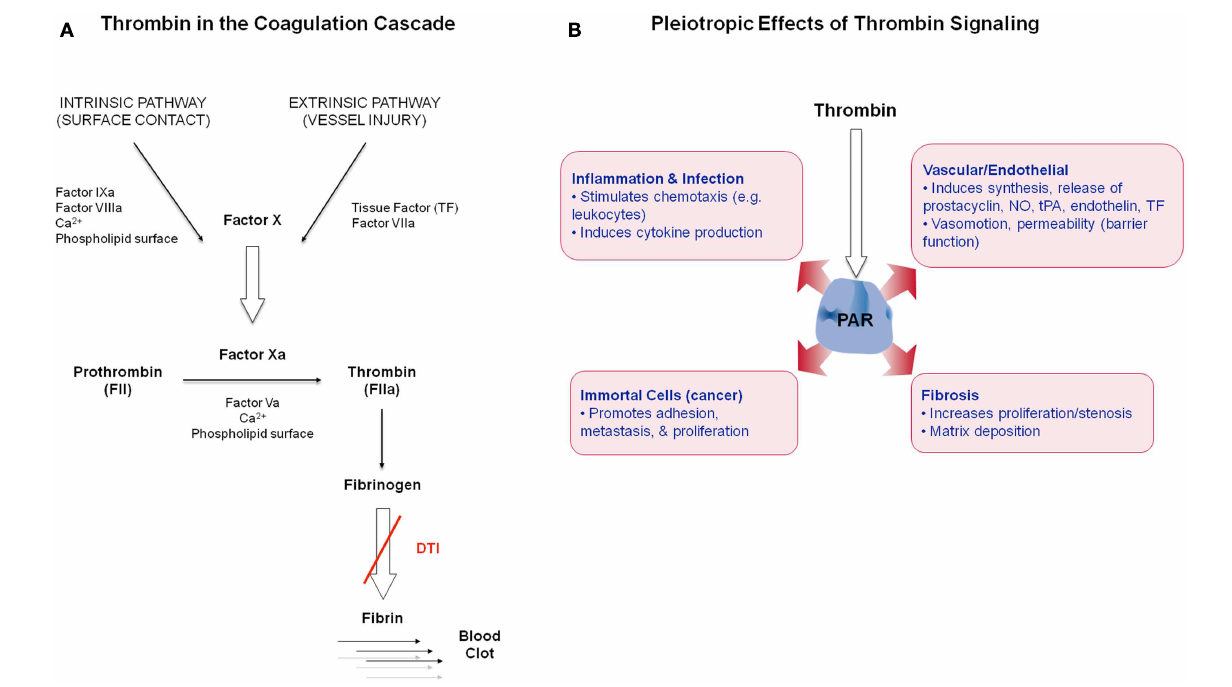
Two additional FXa inhibitors, edoxaban (Furugohri et al.,